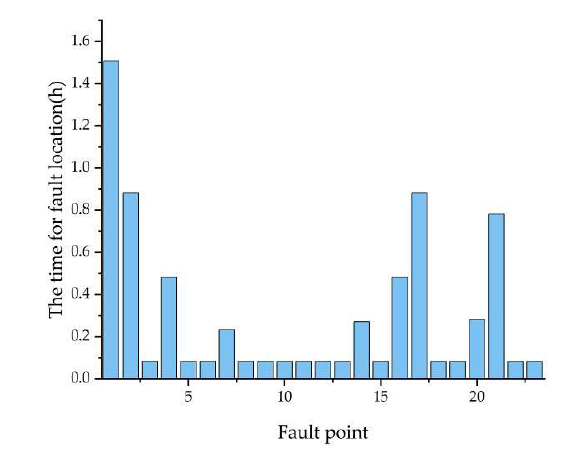
Figure 7. The time required for any fault point to be accurately located.